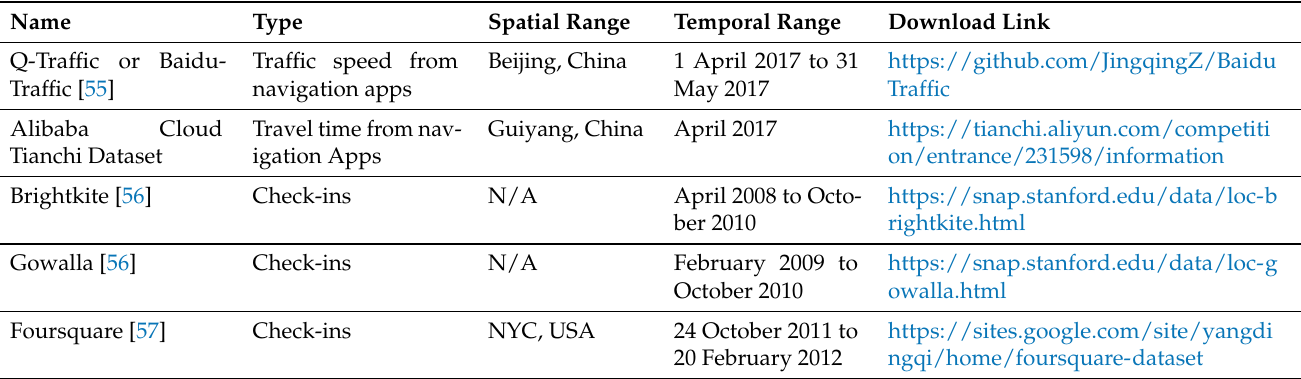
Table 6. The list of open location-based service